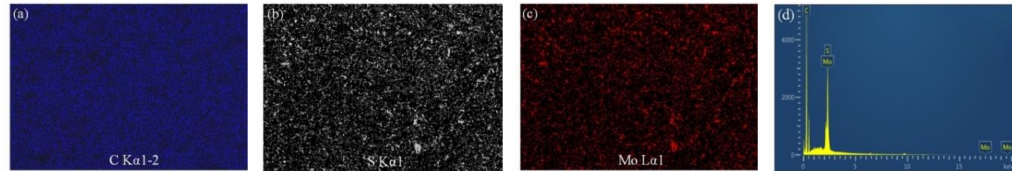
Figure 5. EDS mapping images of PG07PM15. ( a ) C, ( b ) S, ( c ) Mo and ( d ) element scale